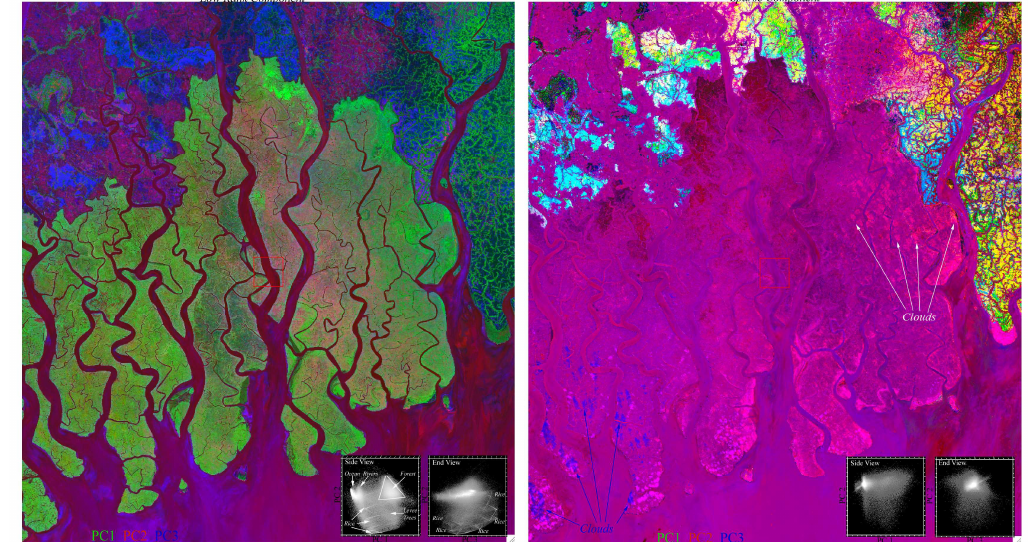
Figure 6. Low order PC composites of RPCA Low Rank and Sparse component HLS S30 vegetation fraction time series. The Low Rank temporal feature space (inset left) clearly separates water from vegetation but also multiple rice phenologies from levee trees from mangrove forest. The Sparse Component contains more transient features like clouds, river sediments and finer scale rice phenology on polders to the north and east of the forest.